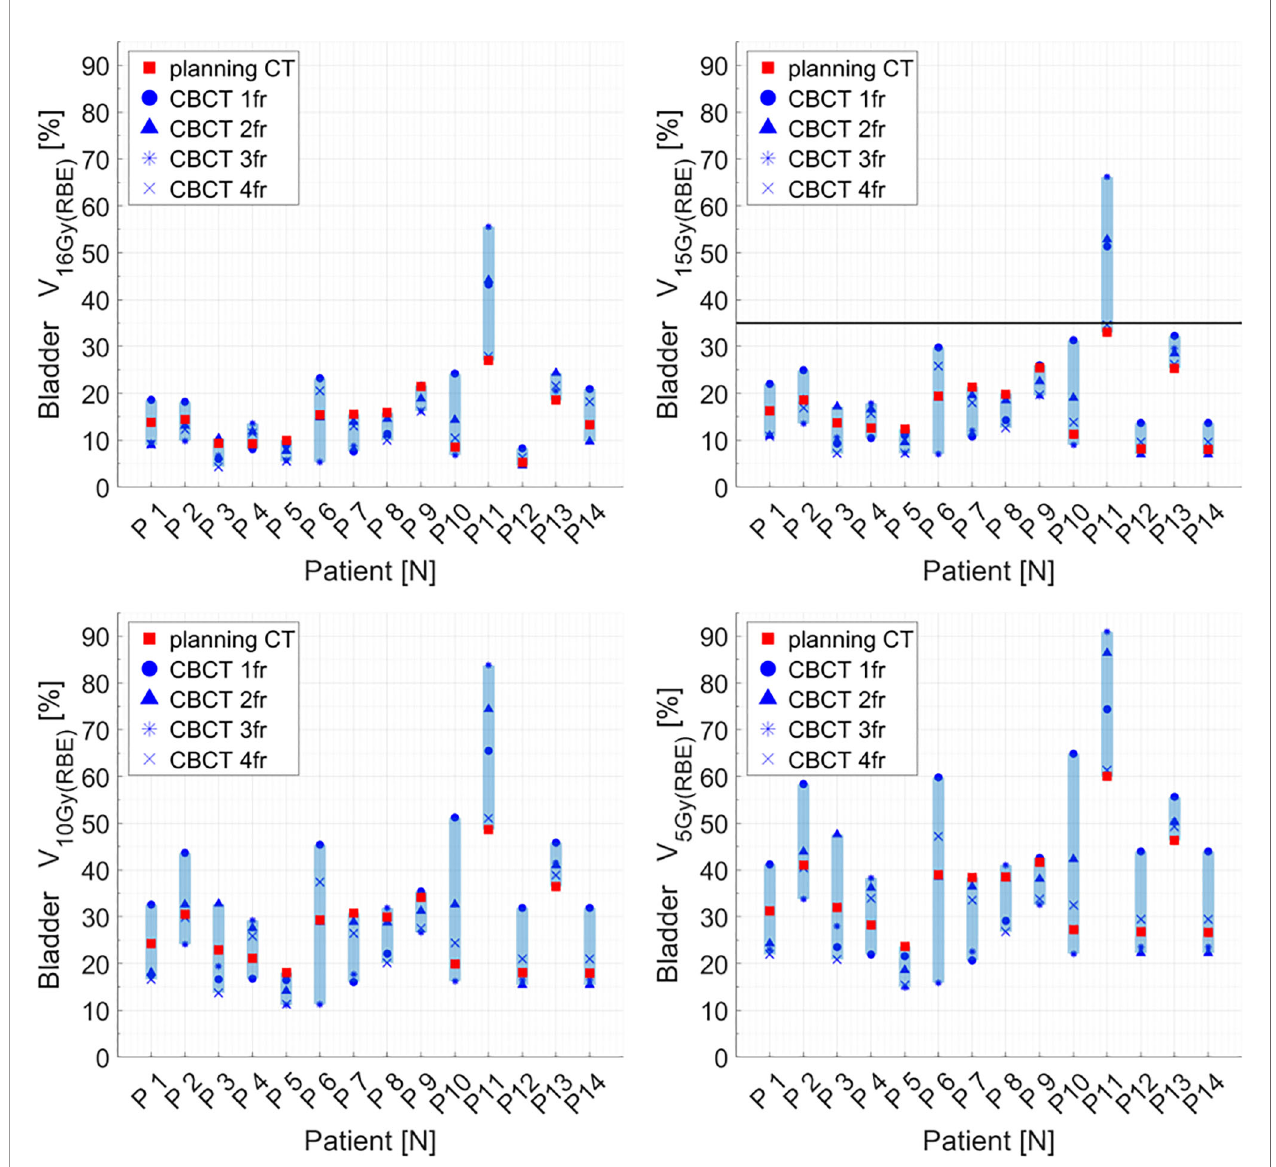
FIGURE 5 | Distribution of bladder dose – volume histogram (DVH) metrics (V 16Gy(RBE) , V 15Gy(RBE) , V 10Gy(RBE) , V 5Gy(RBE) ) for each patient at planning CT (red squares) and at each synthetic CT (sCT) (dark markers). Colored range bars indicate the maximum variation extent within a single patient. The bladder constraint V 15Gy(RBE) ≤ 35% is indicated as a black line. CBCT, cone beam computed tomography; fr,